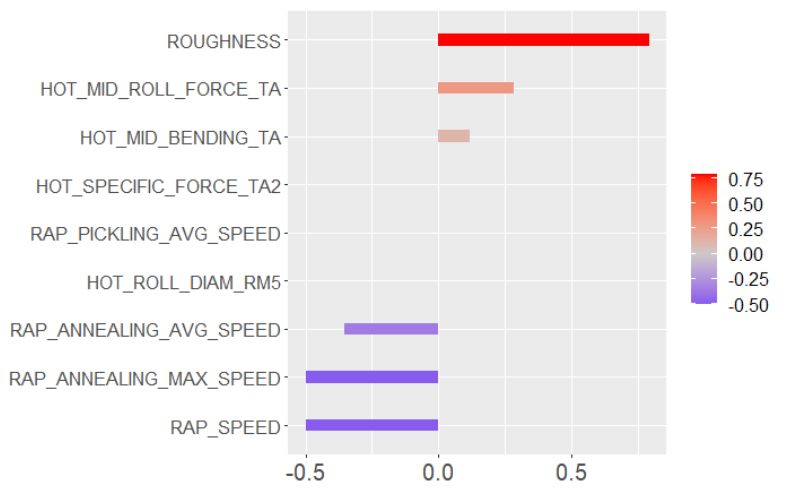
Figure 18. Scaled deviated variable distances that are potential root causes for a bad predicted